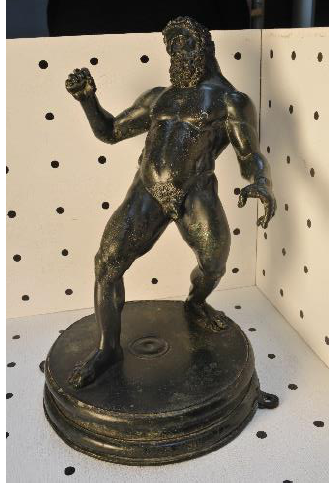
Figure 2. One of the antique decorated bronze exhibited in the Museum of Parma: the Drunken Hercules (“Ercole Ebbro”) statuette case.